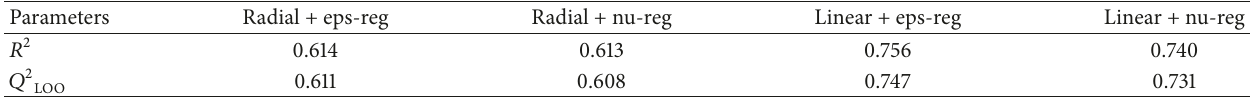
Table 6: 𝑅 2 and 𝑄 2 LOO of 4 SVM models.